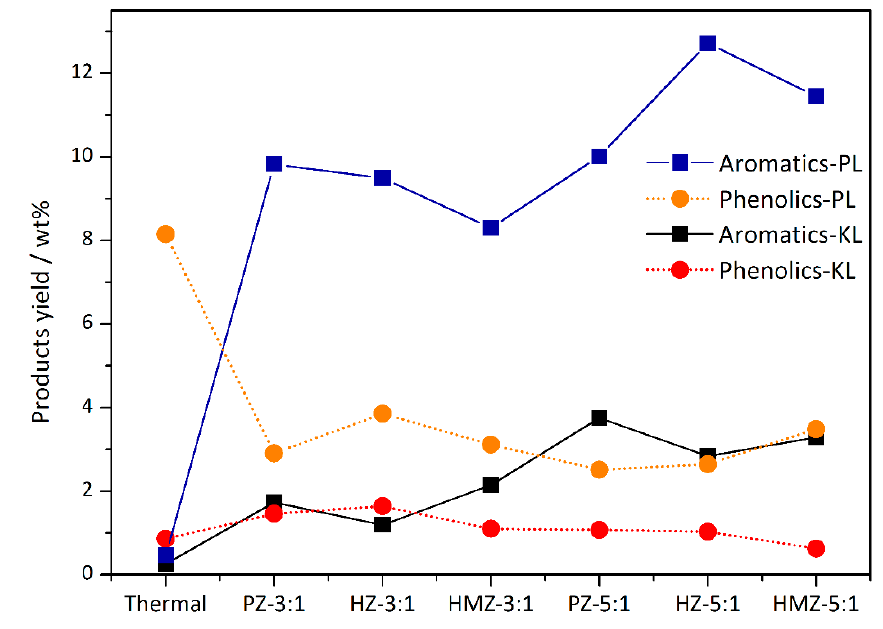
Figure 6. Target products yield of KL and PL CFP.